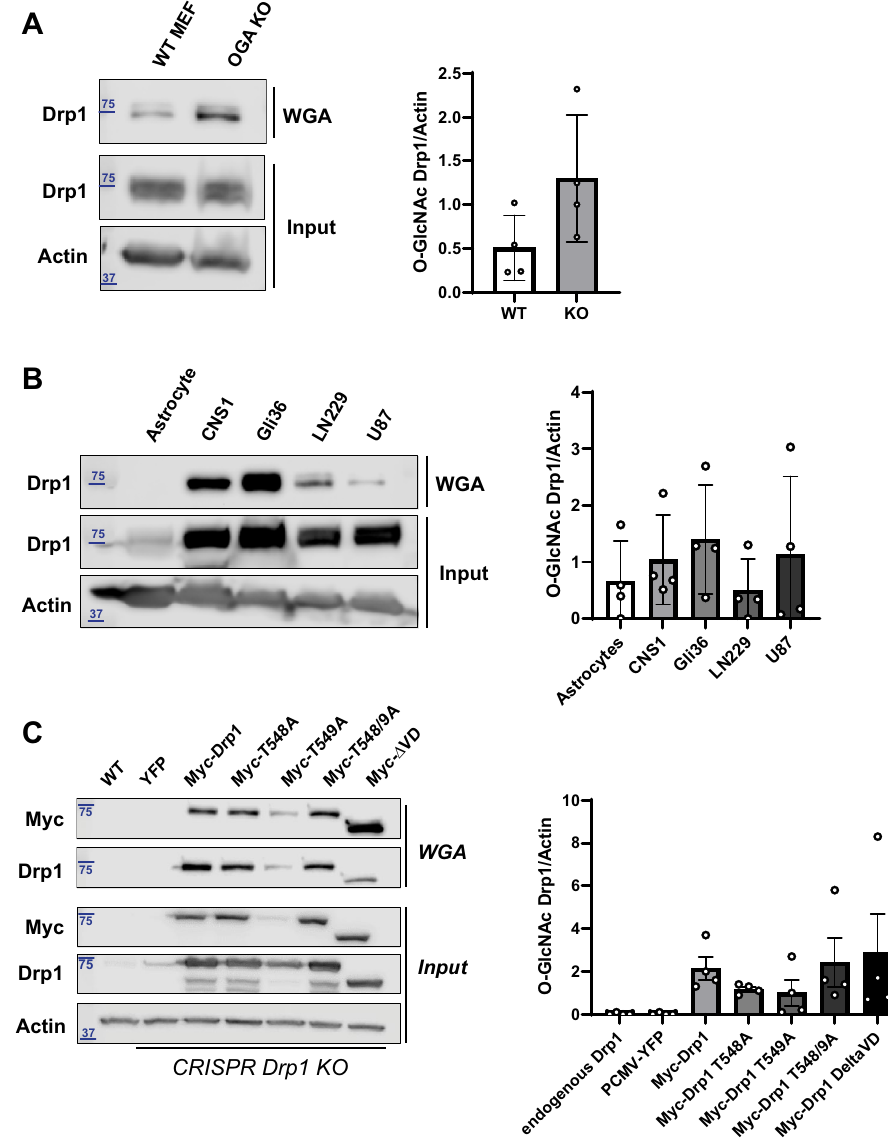
Figure 4. Drp1 O -GlcNAcylation is elevated in OGA KO MEFs, glioblastoma (GBM) cell lines, and sustained on overexpressed Drp1 mutants. ( A ) Western blot analysis of Drp1 within WGA precipitates from WT and OGA KO MEFs is shown and quantified. N = 6, Student’s t test, error bars represent SEM. ( B ) Western blot analysis of Drp1 from WGA precipitation of human astrocytes and glioblastoma cell lines (CNS1, Gli36, LN229, and U87) is presented with quantification. N = 4, Student’s t test, error bars represent SEM. Input is 10% protein concentration of precipitation. ( C ) Western blots of Myc-tagged Drp1 (WT, T548A, T549A, T548/9A, and ΔVD) constructs overexpressed and WGA precipitated from Drp1 CRISPR HCT 116 cells is shown and quantified. N = 4, Student’s t test, error bars represent SEM. Input is 10% protein concentration of precipitation. Full-length Western Blots (uncropped) are provided in Supplementary Figure